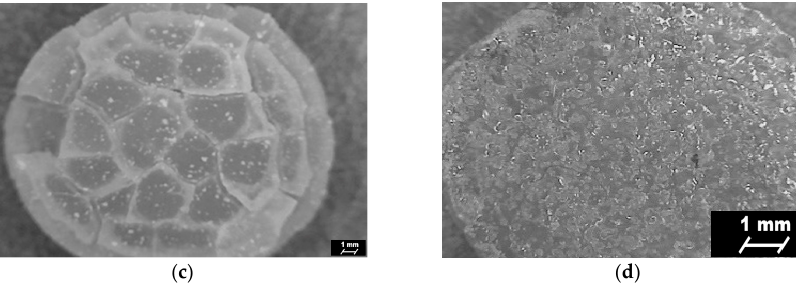
Figure 8. Optical microscope images of PURs-M after ( a ) and after 15 days of short-term interactions study performed in the selected environments: basic ( b ); acidic ( c ); and oxidative ( d ).